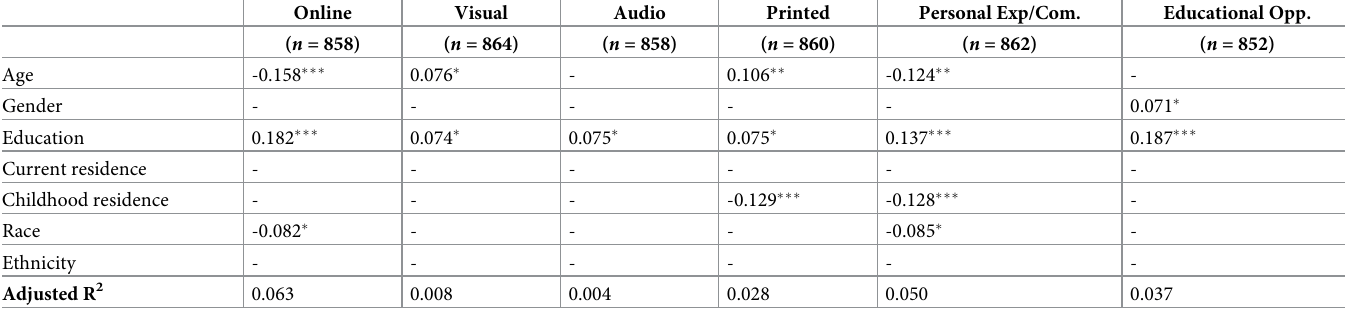
Table 5. Preferences for channels of information on nature-related topics by demographics. Numbers represent standardized beta coefficients from stepwise